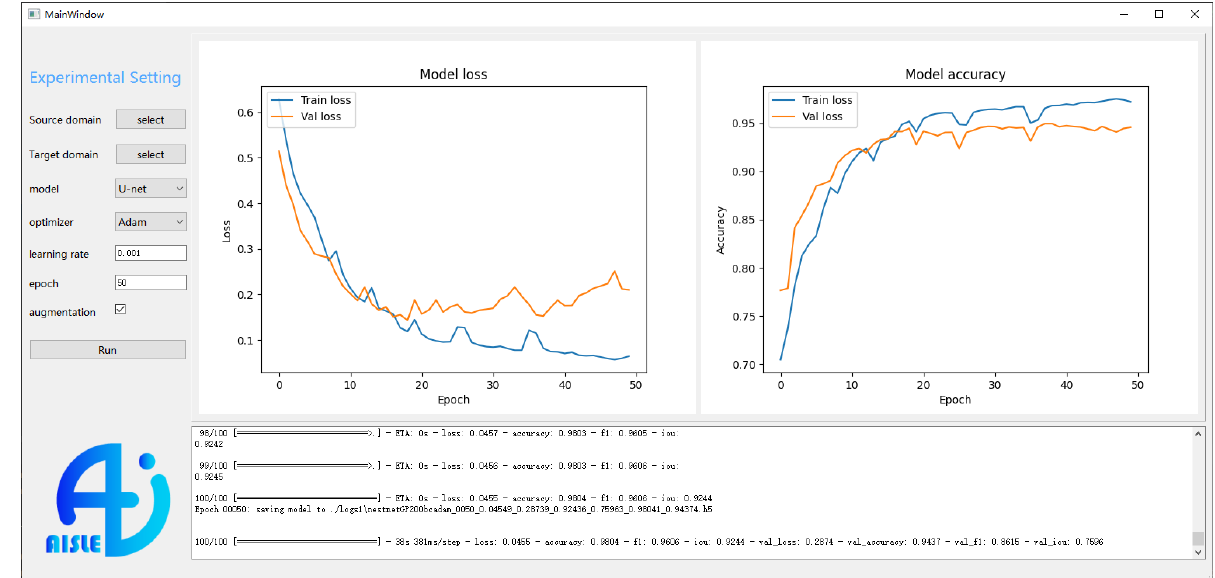
Figure 4. Software interface of deep transfer